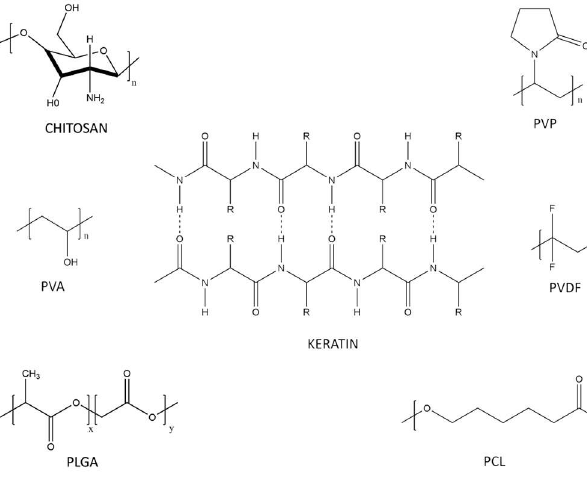
Figure 4. Biopolymer structures used in nanofibers and nanoparticles.